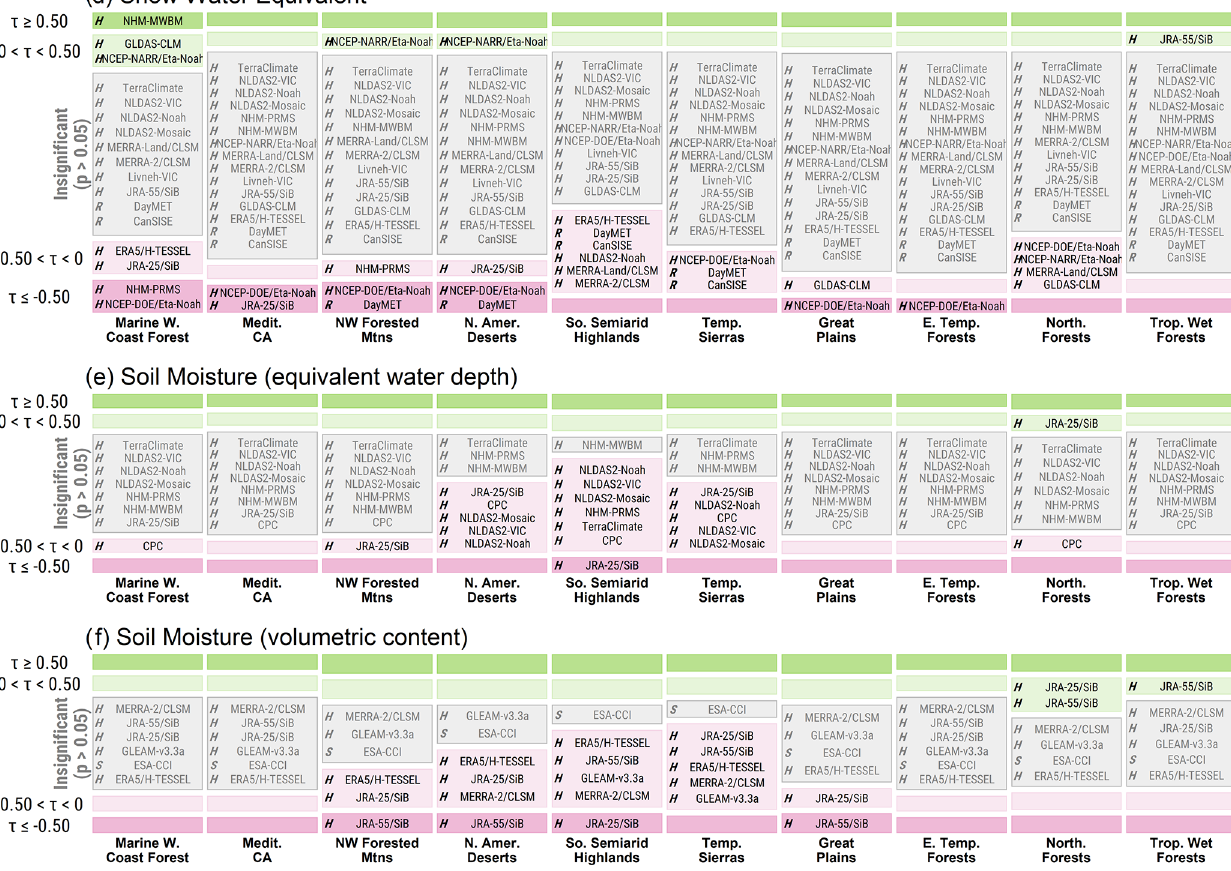
Figure B5. Binned distributions of interannual model trends from 1982 to 2010, measured with Mann–Kendall’s tau ( τ ) for 10 ecoregions, for water balance components of precipitation, evapotranspiration, runoff, snow water equivalent, and soil moisture. Model names are binned into very positive ( τ ≥ 0 . 50; dark green), positive (0 <τ< 0 . 50; light green), negative ( − 0 . 50 <τ< 0; light purple), and very negative ( τ ≤ − 0 . 50; dark purple) significant trends, as well as an insignificant trend box ( p> 0 . 05; gray). Trend significance is assumed when the p value does not exceed 0.05 ( p< 0 . 05). Model categories are denoted with a single letter identifying either a hydrologic ( H ), reanalysis ( R ), or remote sensing ( S )